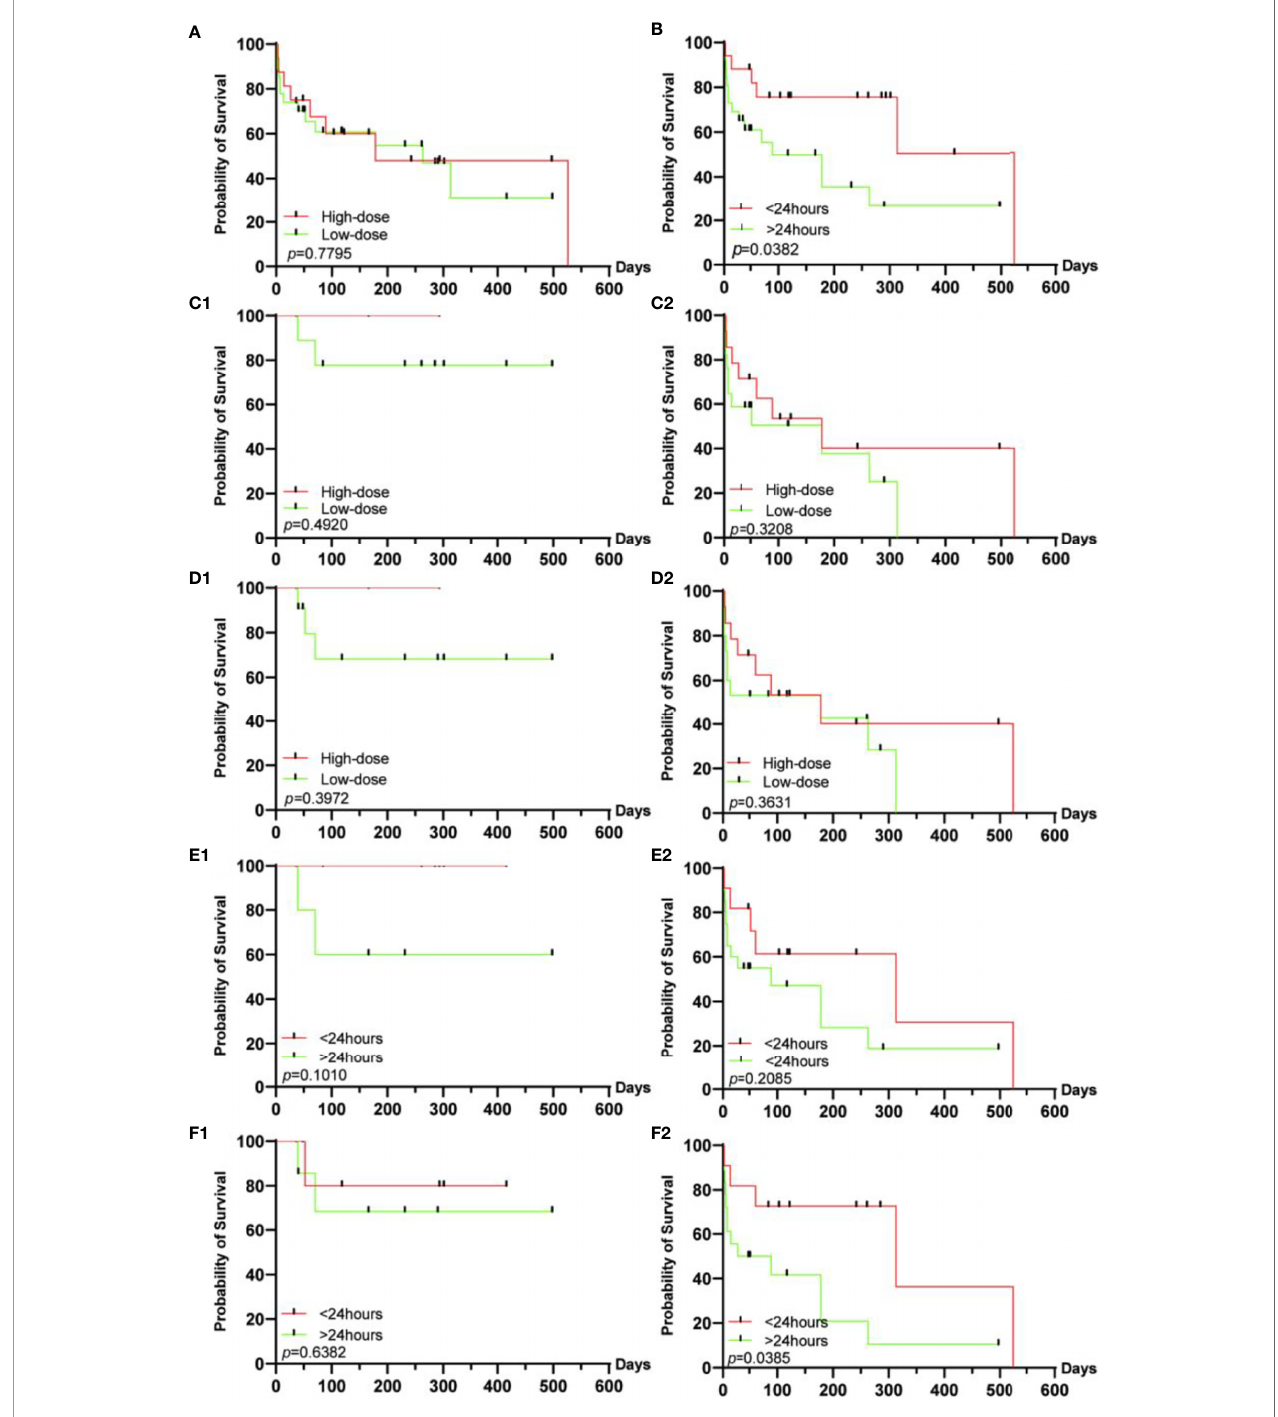
FIGURE 3 | Survival analysis of corticosteroid therapy in different groups. (A) In all patients, the dose of corticosteroids has no signi fi cant effect on survival, (B) while early corticosteroid intervention can improve the prognosis. Regardless of the heart failure grade [0-2 (C1) , 3-4 (C2) ] or the pattern of organ involvement [pure myocarditis (D1) , multi-organ irAEs (D2) ], the dose of corticosteroids has no signi fi cant effect on the prognosis. Regardless of the grade 0-2 (E1) or the grade 3-4 (E2) of heart failure, the intervention time of corticosteroids have no signi fi cant effect on the prognosis. (F1) In pure myocarditis, the duration of hormonal intervention has no signi fi cant effect on the prognosis, (F2) while in patients with multiple organ irAEs, early hormonal intervention can signi fi cantly improve the prognosis of